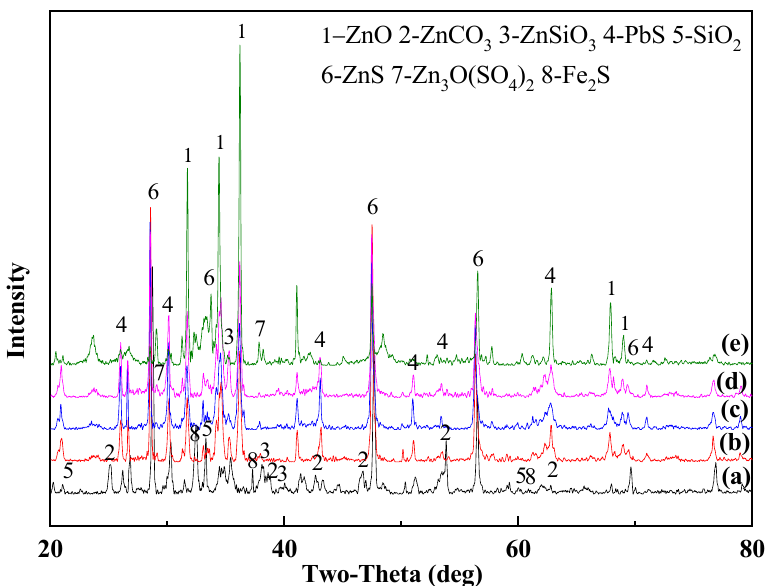
Figure 8. The effects of different roasting temperatures on the XRD patterns of zinc calcines under the microwave roasting condition. ( a ) 200 °C; ( b ) 300 °C; ( c ) 400 °C; ( d ) 500 °C; ( e ) 600 °C.